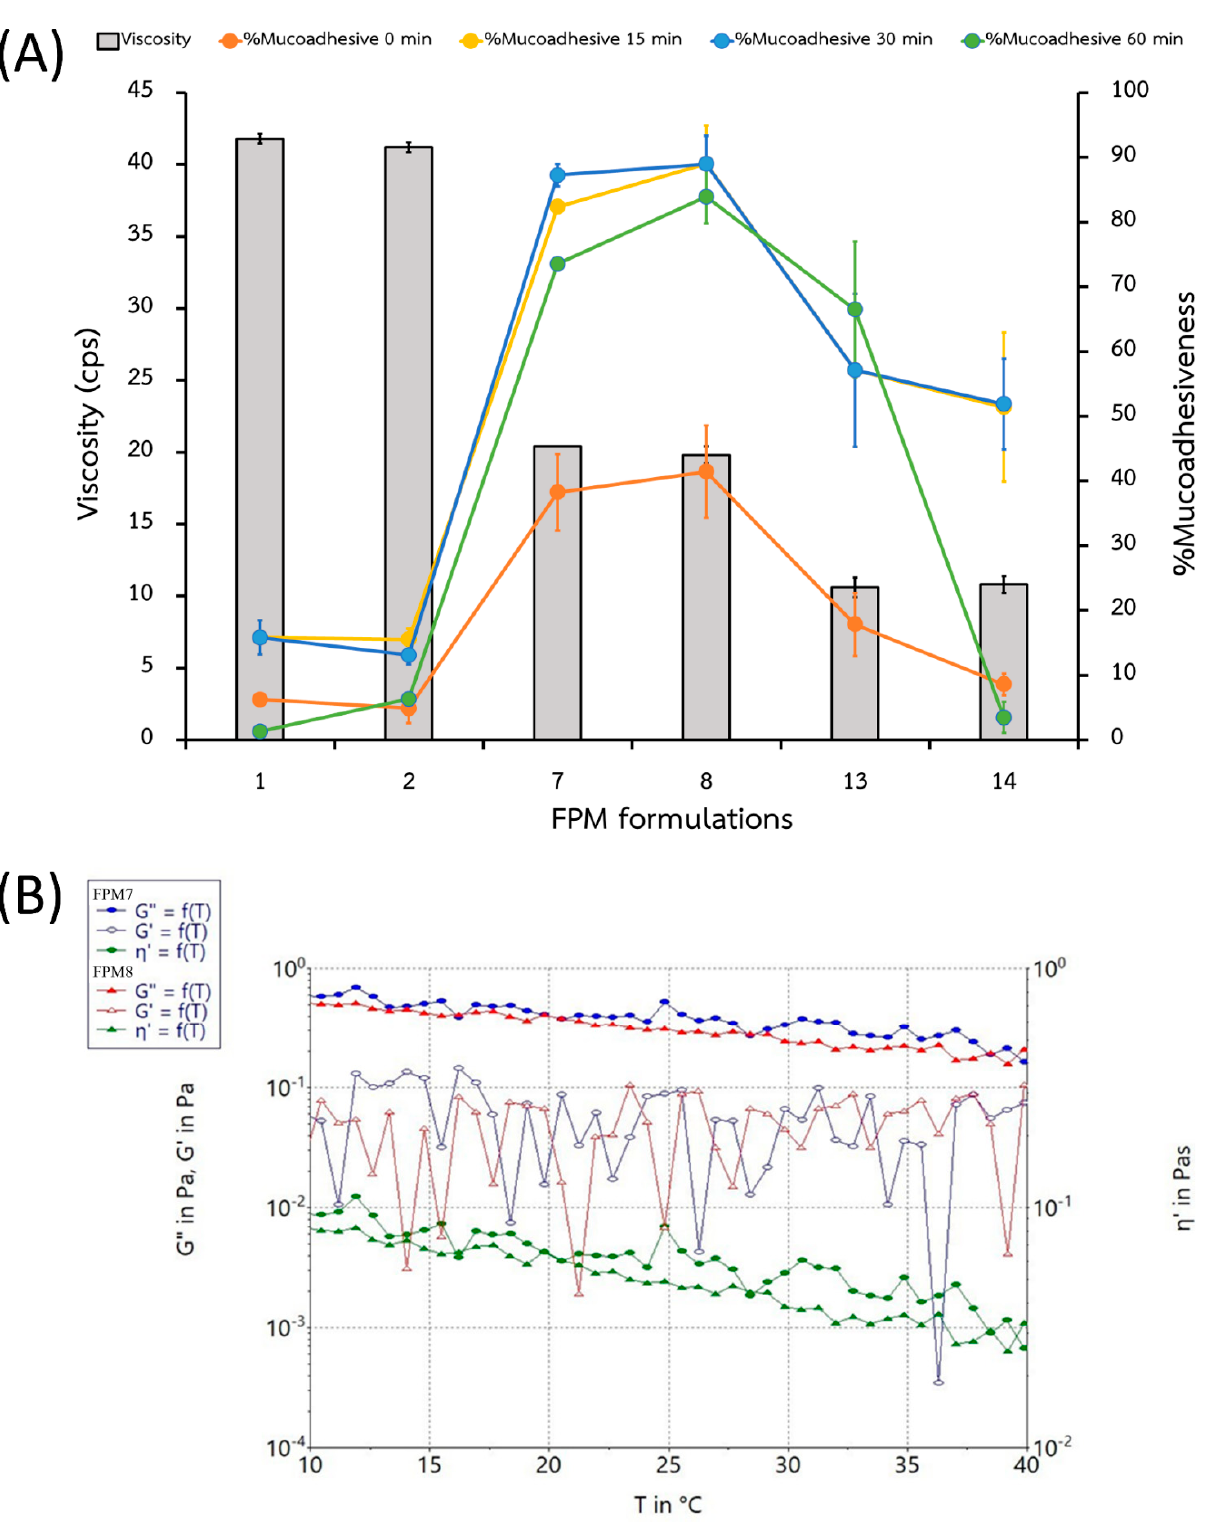
Figure 2. Comparison ( A ) of the formulation viscosity (orange columns) and % mucoadhesiveness at 0 (grey line), 15 (yellow line), 30 (blue line) and 60 min (green line) and ( B ) rheology of FPM7 and FPM8 between 10 °C to 40 °C.